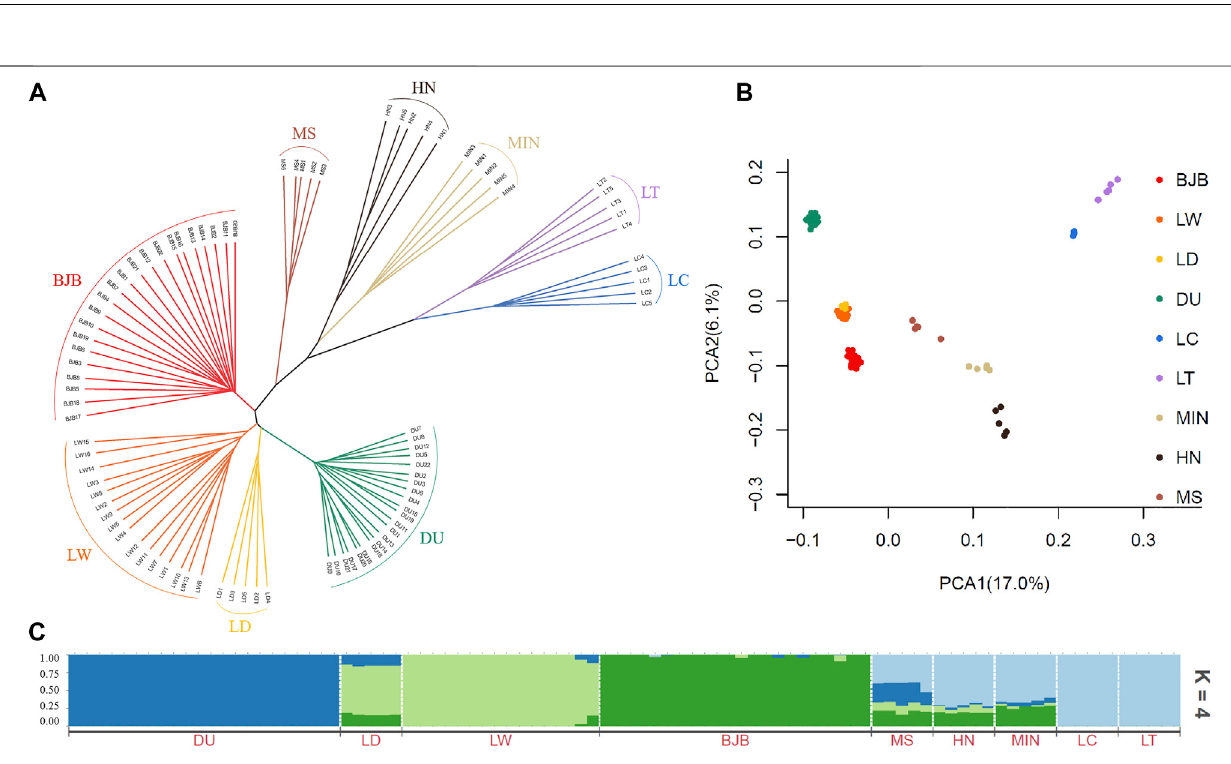
Frontiers in Genetics |